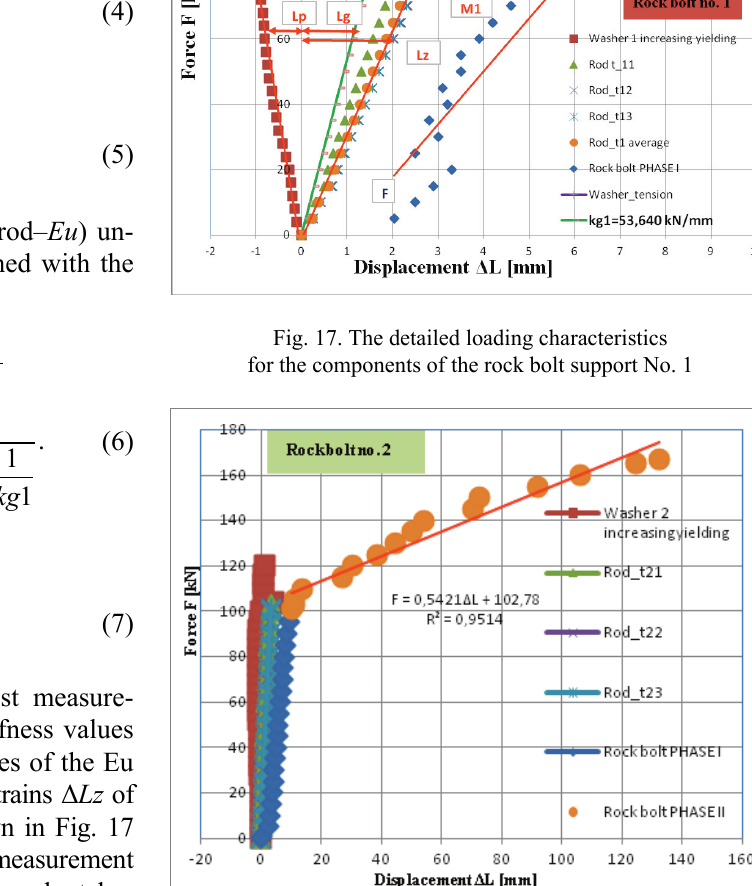
Fig. 18. The full loading characteristics for bolt No. 2 with the deformable component